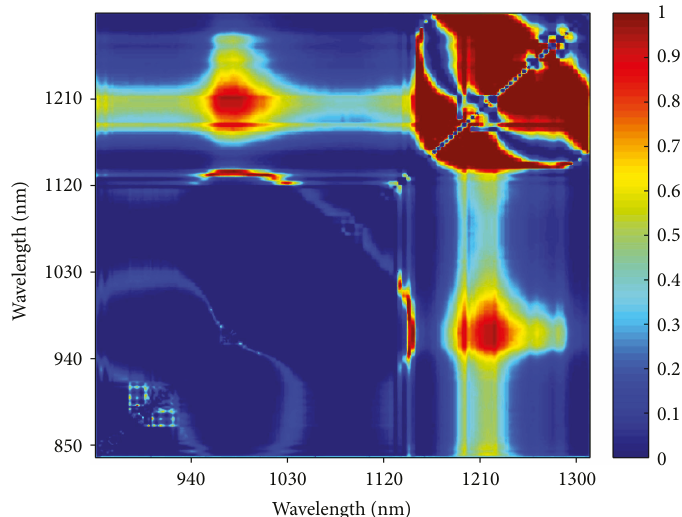
Figure 9: Correlation coe ffi cients between the vegetation index and water content under di ff erent band combinations.